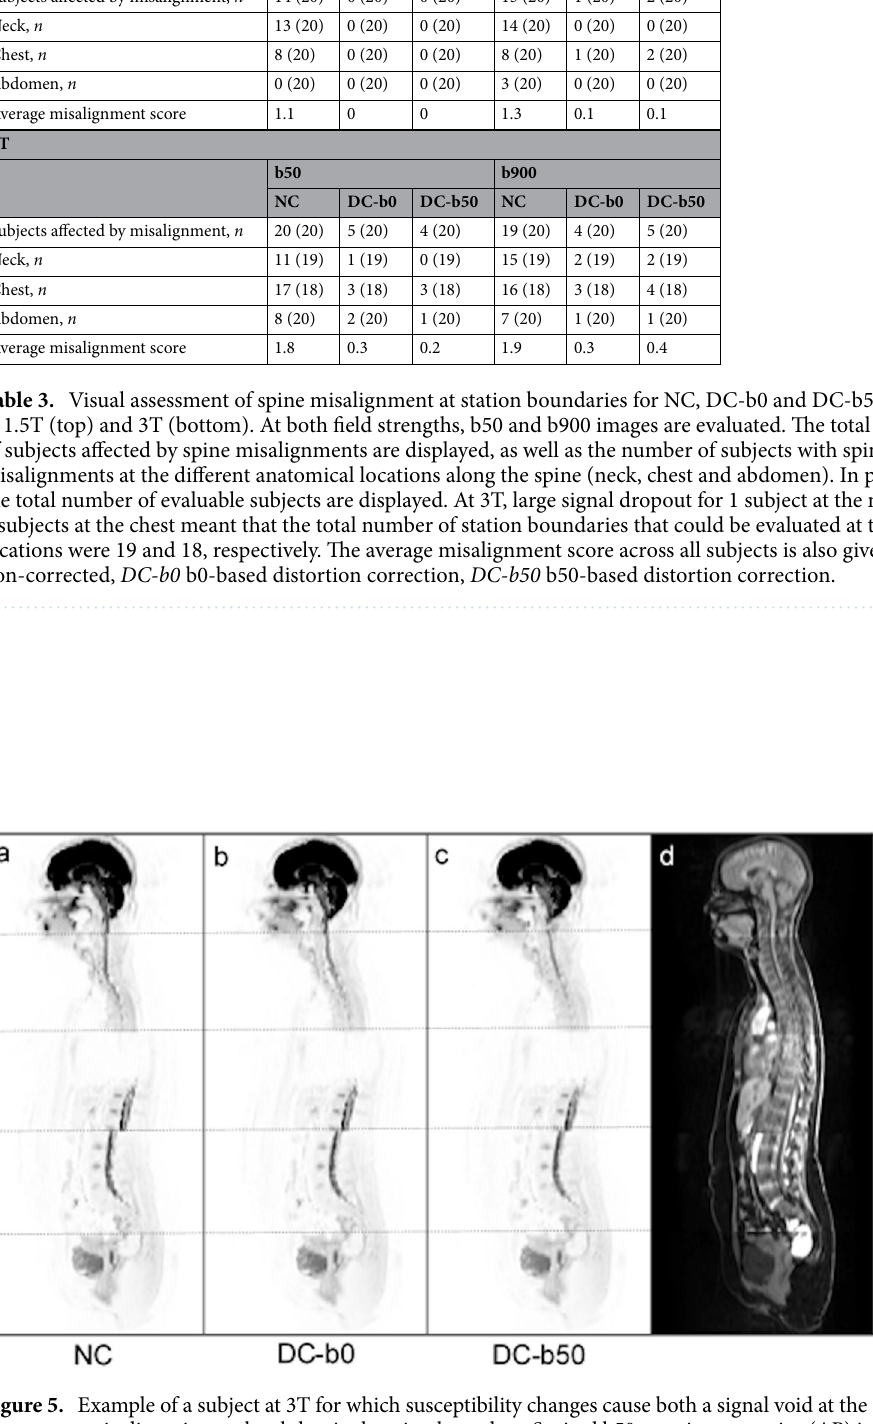
Figure 5. Example of a subject at 3T for which susceptibility changes cause both a signal void at the chest and large geometric distortion at the abdominal station boundary. Sagittal b50 anterior–posterior (AP) images are shown in inverted grey-scale: ( a ) non-corrected (NC), ( b ) b0-based distortion corrected (DC-b0) and ( c ) b50- based distortion corrected (DC-b50). The corresponding structural image is also shown ( d ). Station boundaries are marked with a dotted line and inter-station signal intensity correction was performed for the purpose of visualization 23 . The signal drop-out resulted in spine misalignment not being assessed at the chest station boundary. The geometric distortion seen as a spine misalignment at the abdominal station boundary could not be corrected by either the b0- or b50-based distortion